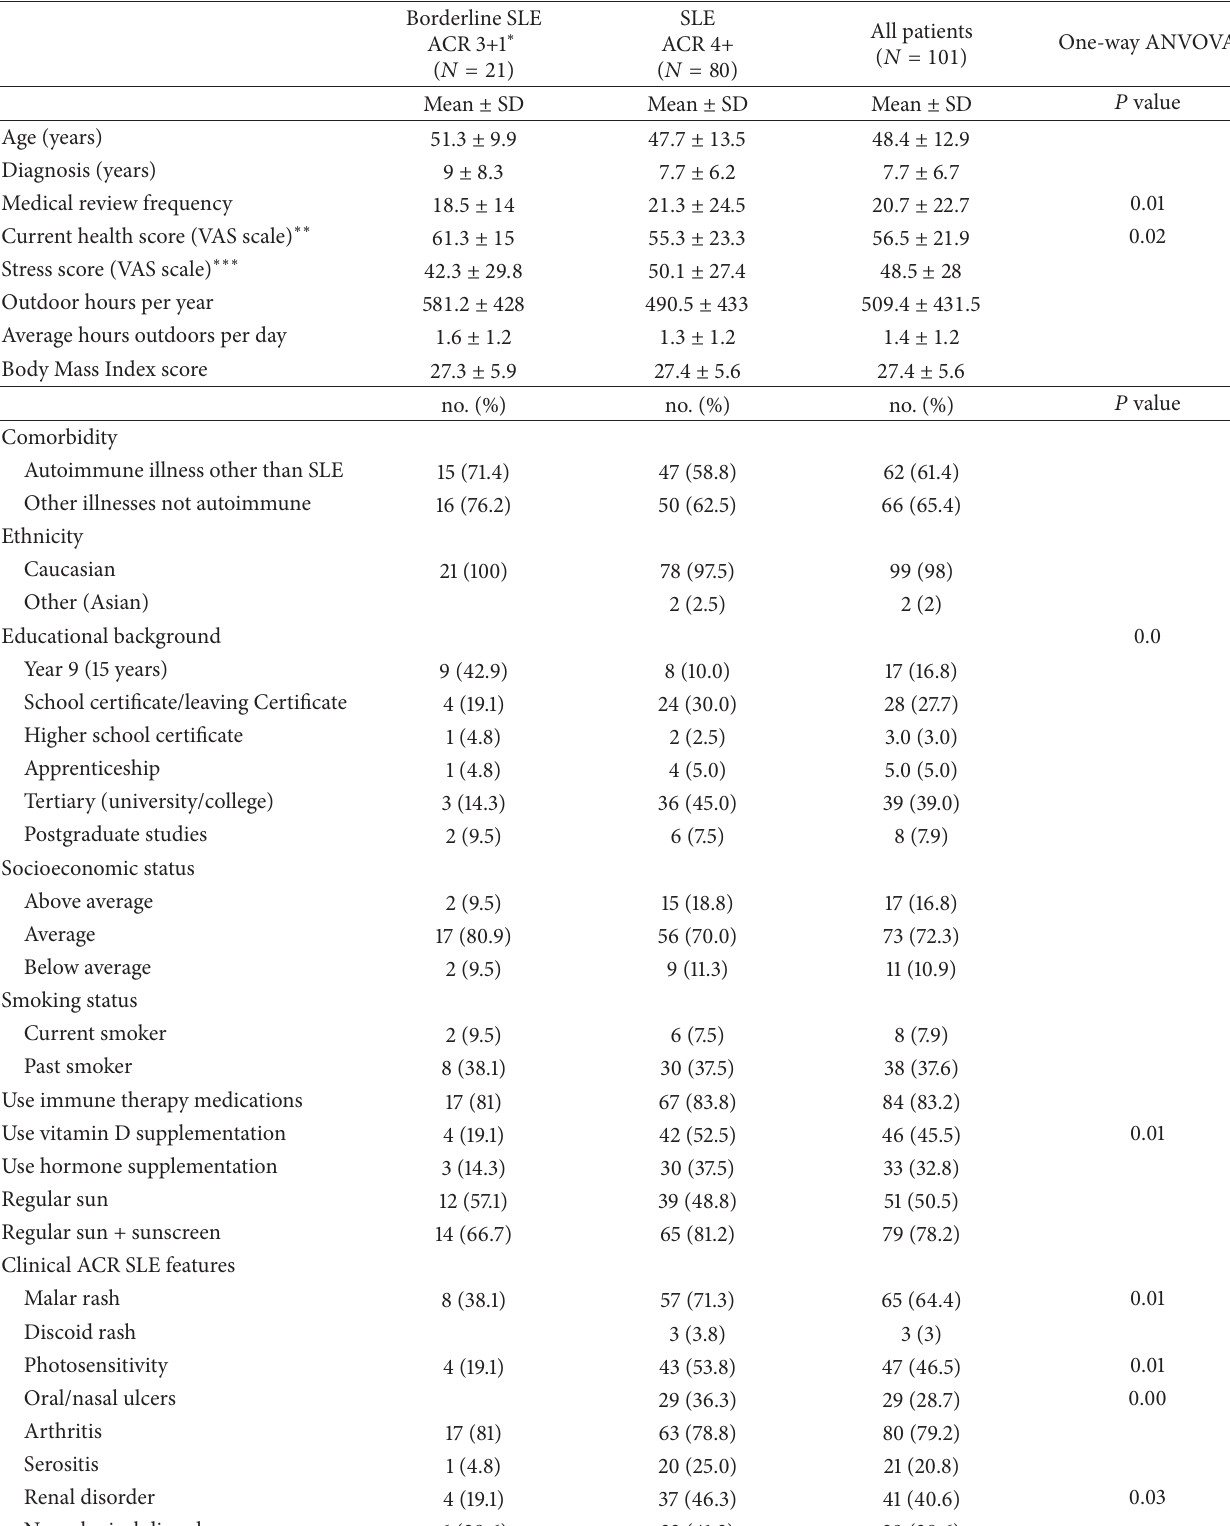
Table 1: Demographic characteristics of patient participant